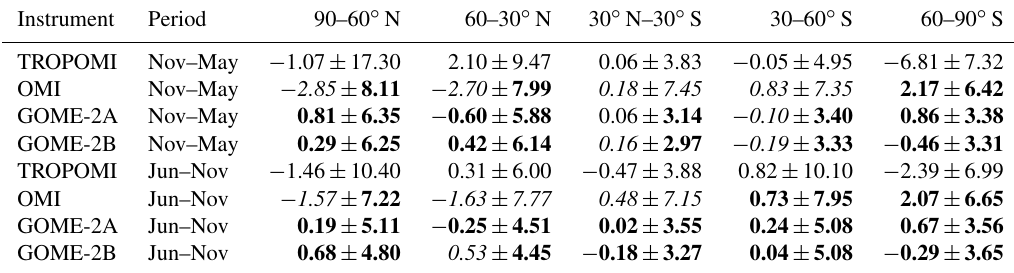
Table 3. Mean bias and standard deviations of the TCO3 retrievals against the CAMS ozone analysis inDU from the control experiment (CTRL) for the periods 26 November 2017 to 3 May 2018 and 11 June to 30 November 2018. Numbers in bold mark where the biases and standard deviations of the other TCO3 data sets are smaller than in TROPOMI, italic marks where they are larger. Only good data are shown for TROPOMI and used data for the other